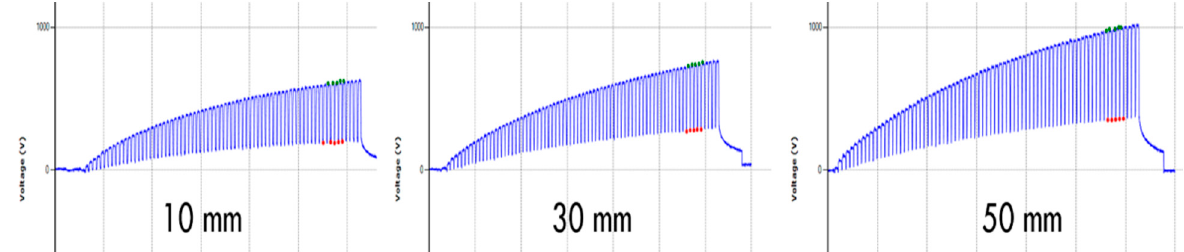
Figure 10. Effect of different stepping height on the electrostatic waveform.